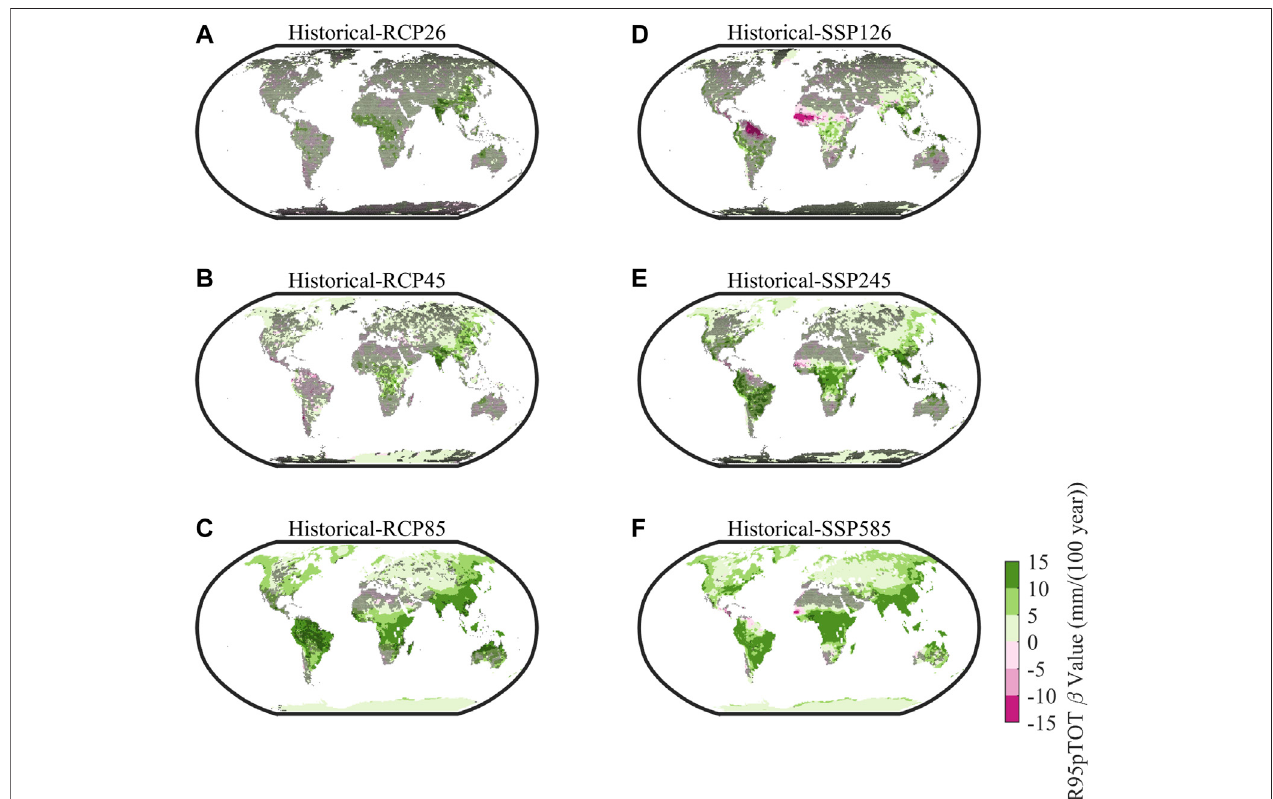
FIGURE 5 | The spatial distributions of the Sen ’ s slope estimator test ( β ) for multi-model mean R95pTOT. It shows β values of the long series precipitation (1982 – 2100) under different future scenarios in CMIP5 (A – C) and CMIP6 (D – F) . The points represent non-signi fi cant trend at the 99% con fi dence level based on the MK